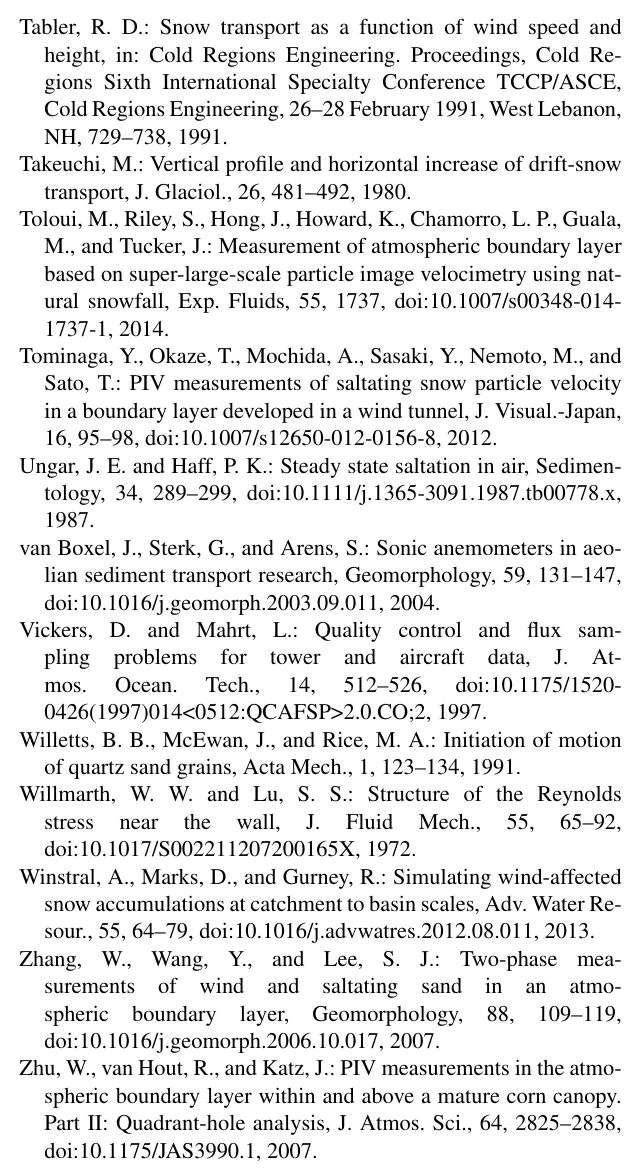
Tabler, R. D.: Snow transport as a function of wind speed and height, in: Cold Regions Engineering. Proceedings, Cold